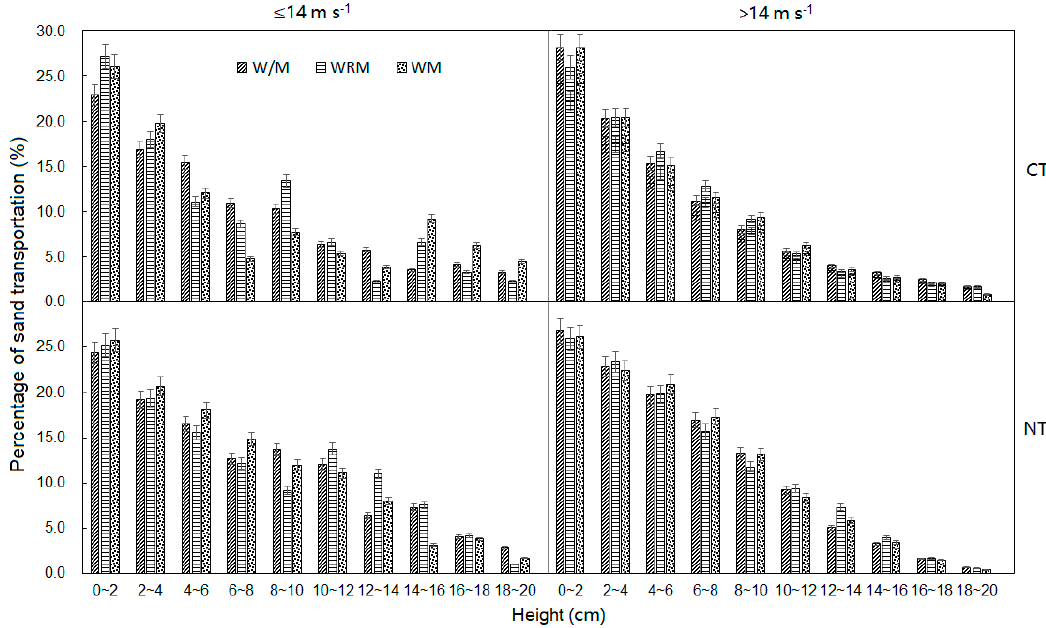
Figure 3. Percentage of sand transportation as affected by cropping system, tillage method, and wind velocity and height during two years. Note: CT, conventional tillage without wheat straw retention; NT, no-tillage with 25–30 cm tall wheat straw; W/M, annual wheat/maize strip intercropping; WRM, two-year wheat-winter rape-maize rotation; WM, two-year wheat-maize rotation. Error bars are standard errors of the means.